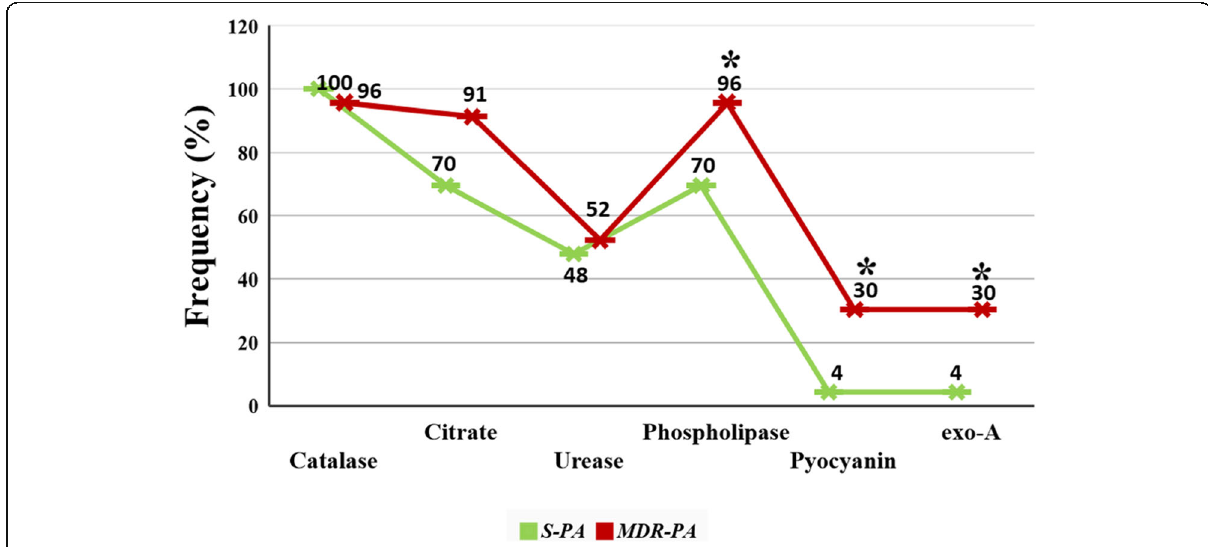
Fig. 2 Graphic representation of frequency of enzymatic virulence factors (catalase, citrate, urease,phospholipase, pyocyanin and exo-A) expression. Pearson ’ s Chi-square test was used for the statistical analysis and data are represented as the mean from three sets of independent experiments. ** p ≤ 0.01, * p < 0.05